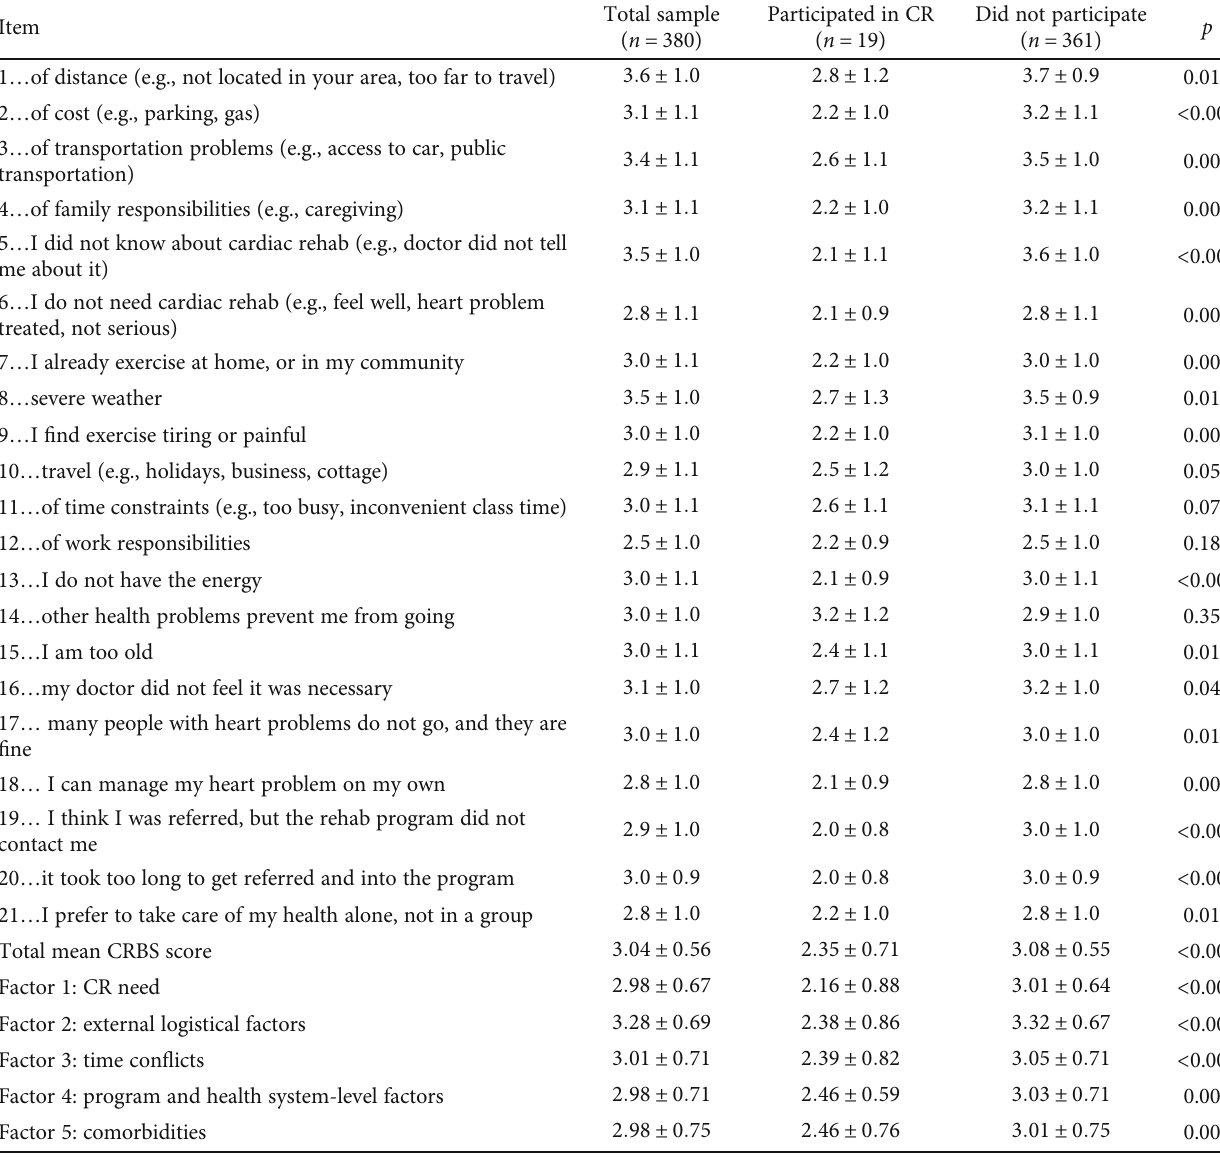
Table 4: Mean CRBS item and subscale scores (standard deviation) by CR